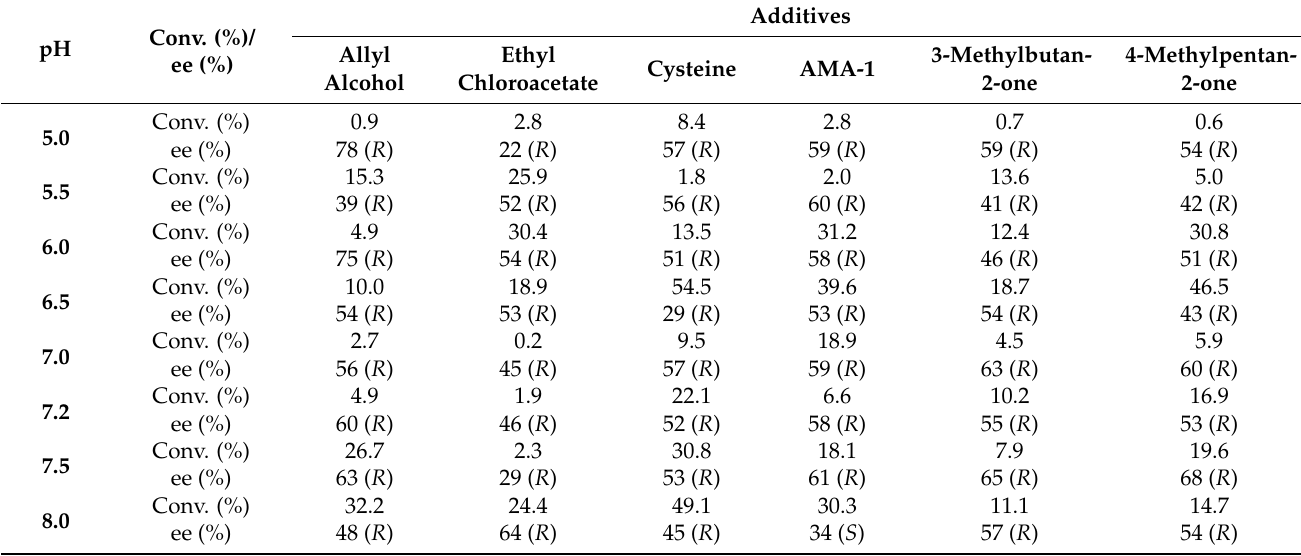
Table 9. Microbial Bioreduction of 1 Catalyzed by A. pullulans Strain DSM 14940 and DSM 14941 in Phosphate Buffer at Different pH Values with